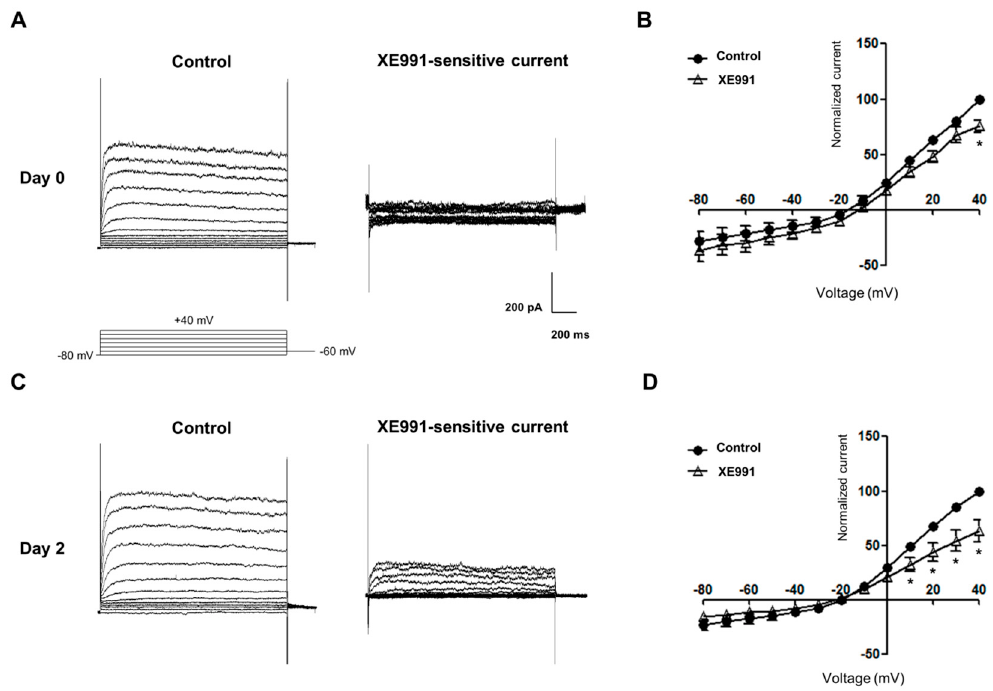
Figure 4. Cont. Figure 4.